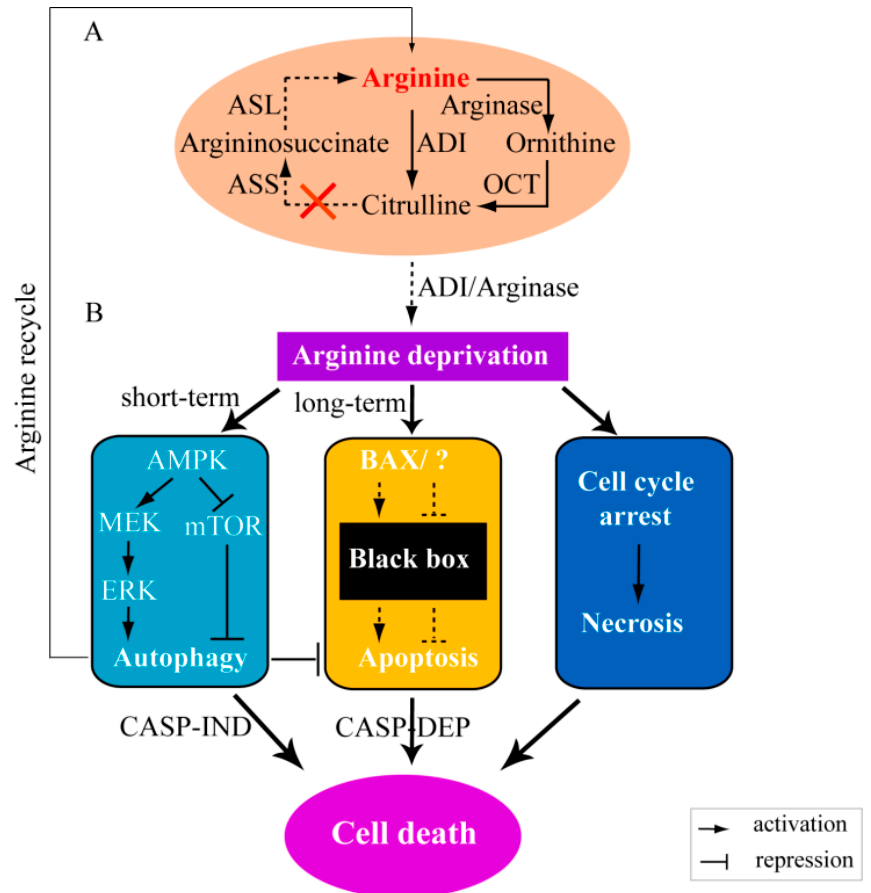
Figure 3. Schematic representation of argininosuccinate synthetase (ASS)-negative cell death induced by arginine deprivation. In ASS-negative cells, arginine cannot synthesize so arginine depletion by ADI or arginase would induce a quick response of cell autophagy by the mammalian Target of Rapamycin (mTOR) or MEK-ERK pathway. Autophagy could recycle limited arginine and prevent apoptosis as a survival response in the short term. Instead, in long-term arginine deprivation, autophagy would contribute to caspase-independent (CASP-IND) cell death and caspase dependent (CASP-DEP) apoptosis could also happen. The dashed lines ( ) means